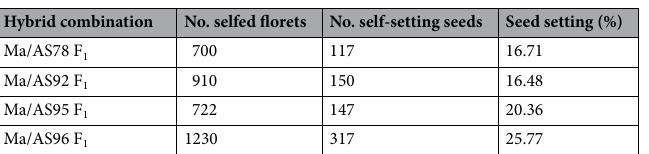
Hybrid combination No. selfed florets No. self-setting seeds Seed setting